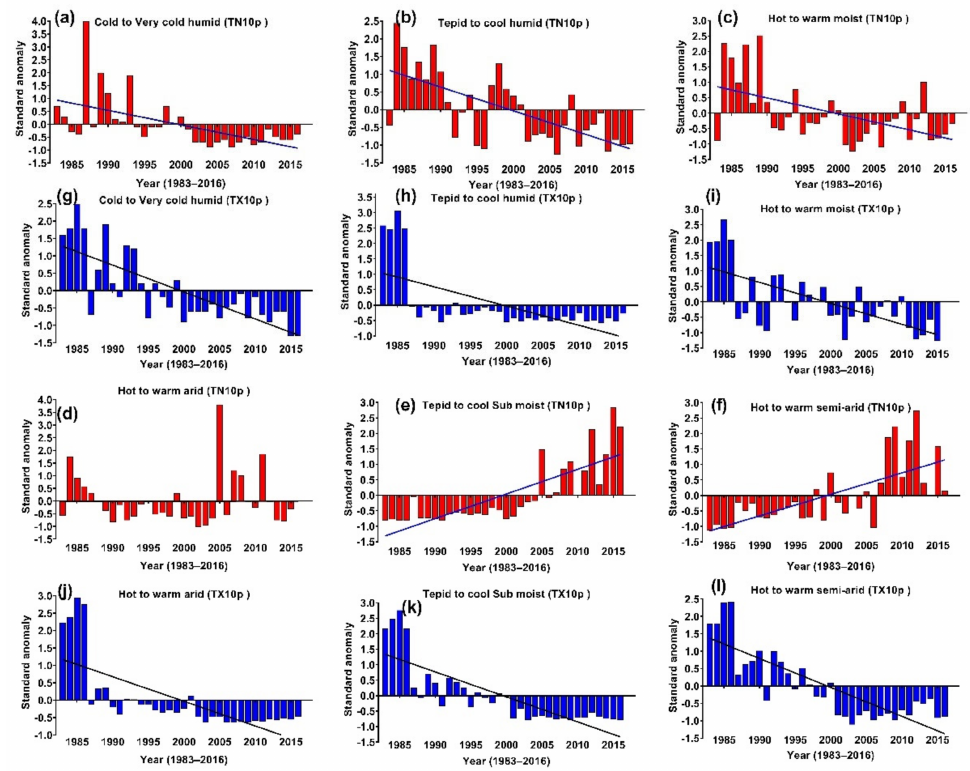
Figure 4. Cool nights (TN10p) ( a – f ) and cool days (TX10p) ( g – l ) over agroecological zones for the period